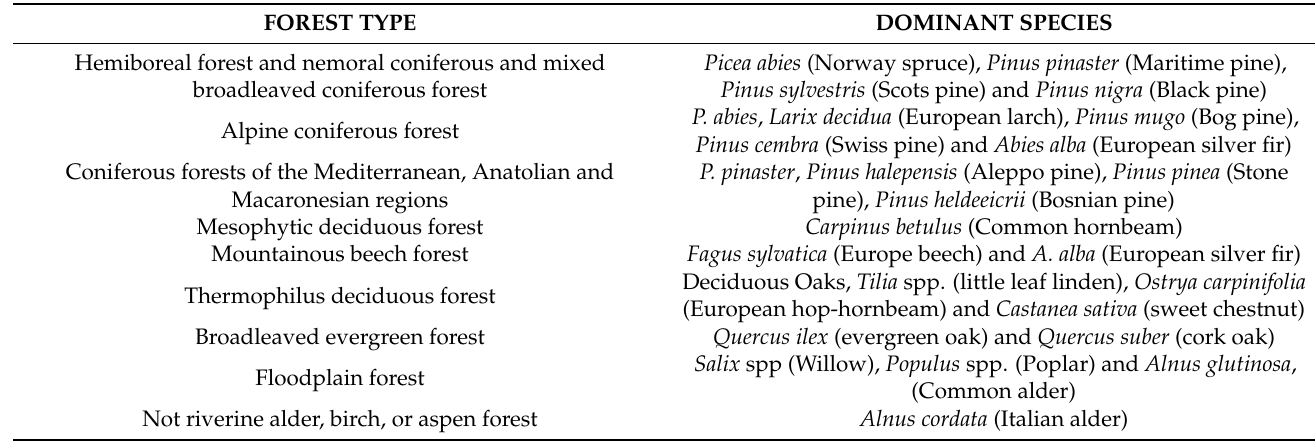
Table 1. The forest types present in Italy according to the National Forest Inventory of 2005 1 and the European Atlas of Forest Tree Species 2